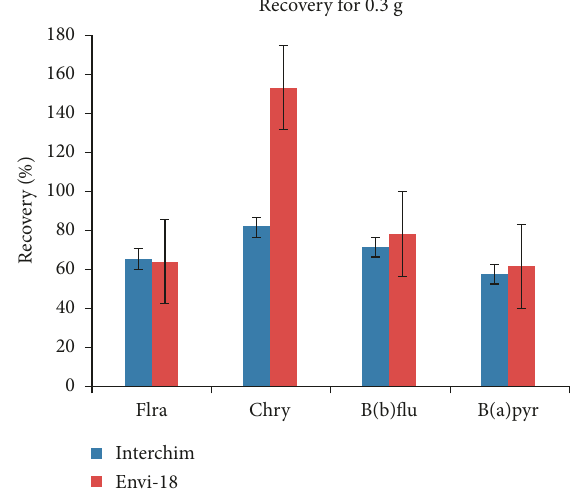
Figure 3: Comparison of the best two sorbents using a dosage of 0.3 grams: fluoranthene (Flra), chrysene (Chry), benzo(b)fluo- ranthene (B(b)flu), and benzo(a)pyrene